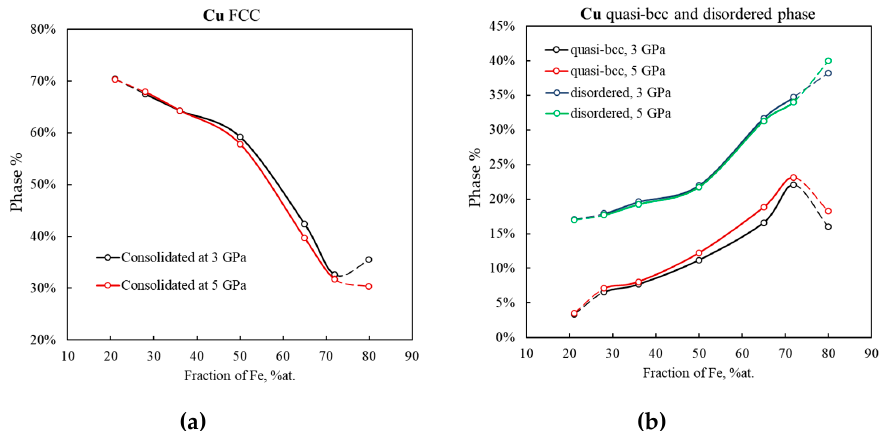
Figure 7. Relative amounts of the fcc phase ( a ) and quasi-bcc and disordered phase (including atoms on pore surface) ( b ) in the copper component of Fe–Cu samples cold sintered at 3 and 5 GPa as a function of Fe content. The rightmost and leftmost parts of the plots are dashed to indicate that the 21/79 and 80/20 Fe–Cu model powders were made up from a different set of nanoparticles (see 2.4). In addition to the phases discussed above, a small amount (7.5–11.5%) of hcp ‐ Cu is present in the simulated samples, the highest value corresponding to the maximum Fe content (80%) and the highest consolidation pressure (5 GPa). As seen from the a ‐ CNA results in Figure 6 (upper row), the hcp phase appears as flat, 1–2 (seldom 3–4) atomic ‐ layers ‐ thick bands (red) that interrupt the regular